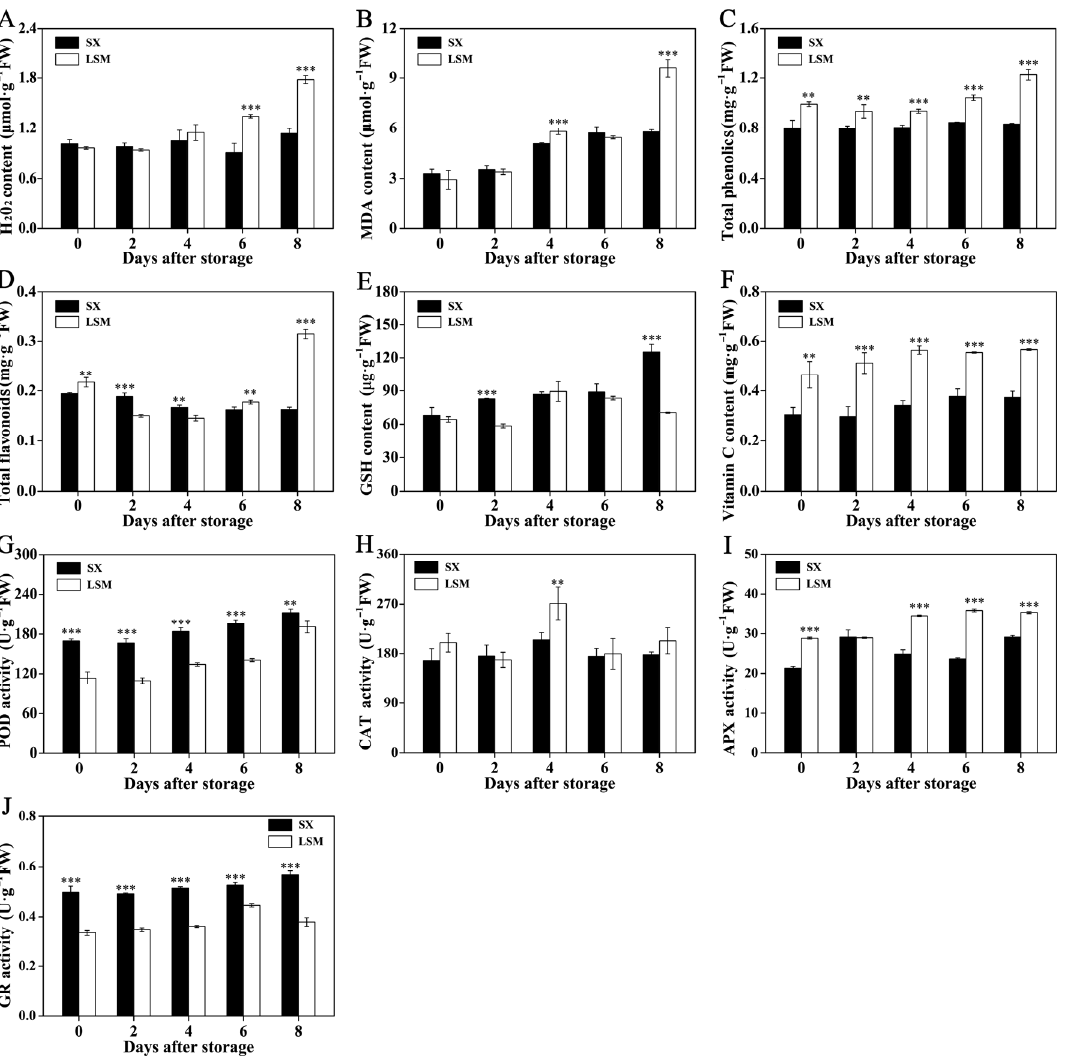
Figure 3. The content of H 2 O 2 and antioxidants as well as activities of radical-scavenging enzymes of 'Shixia' and 'Luosanmu' longan aril during the room-temperature storage. ( A ) H 2 O 2 content, ( B ) MDA content, ( C ) TPC, ( D ) TFC, ( E ) GSH content, ( F ) VC content, ( G ) POD activity, ( H ) CAT activity, ( I ) APX activity, ( J ) GR activity. **: 0.001 < p < 0.01; ***: p < 0.001. FW: fresh